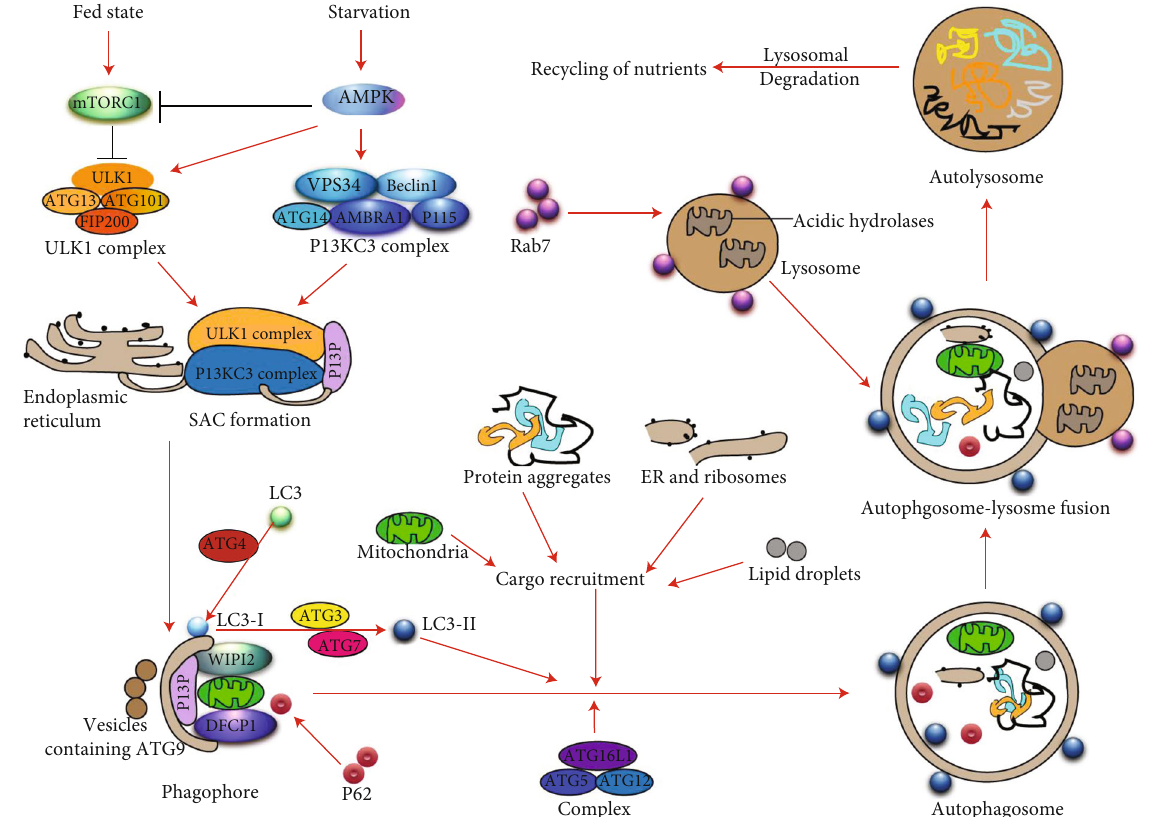
Figure 1: Schematic model represents the overview of the autophagy process. Molecular regulation of the autophagic process in normal and starvation conditions is presented. In the presence of su ffi cient nutrients, activation of mTOR inhibits the ULK1 complex, whereas, under conditions of nutrient starvation, AMPK inhibits mTOR and activates the ULK1 and PI3KC3 complex leading to initiation of phagophore biosynthesis. During autophagosome maturation, cargo recruitment takes place through the recruitment of ATGs and LC3, and mature autophagosome formation occurs. Ultimately, the autophagosome fuses with a lysosome, facilitated by Rab7 and LAMP proteins. The fully functional autolysosome then degrades the autolysosomal cargo and releases the degradation products into the cytosol for